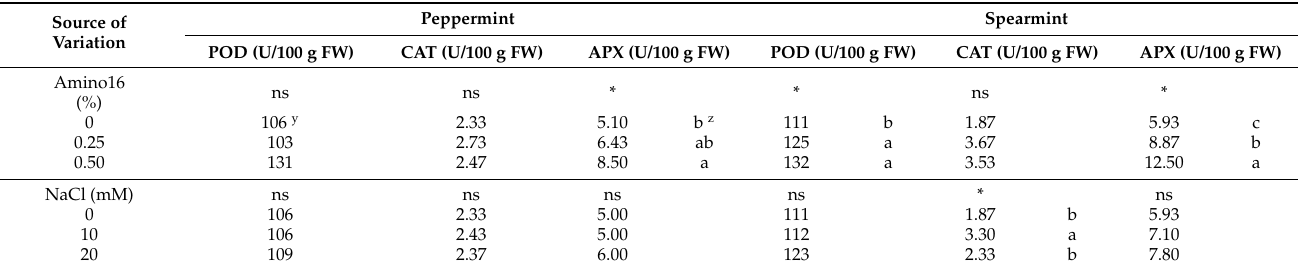
Table 2. Peroxidase (POD), catalase (CAT) and ascorbate peroxidase (APX) enzyme activities of peppermint and spearmint plants grown hydroponically in a floating system on a nutrient solution supplemented either with 0, 0.25 or 0.50% of a commercial amino acid solution (Amino16 ® , EVYP LLP) or 0, 10 and 20 mM NaCl.